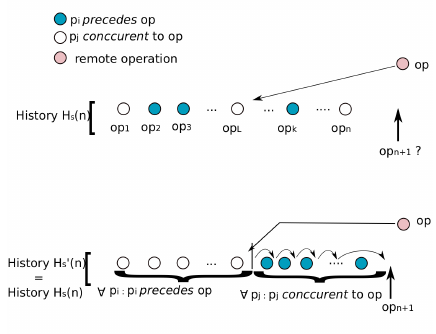
Figure 7. Integrate a remote operation in SOCT2